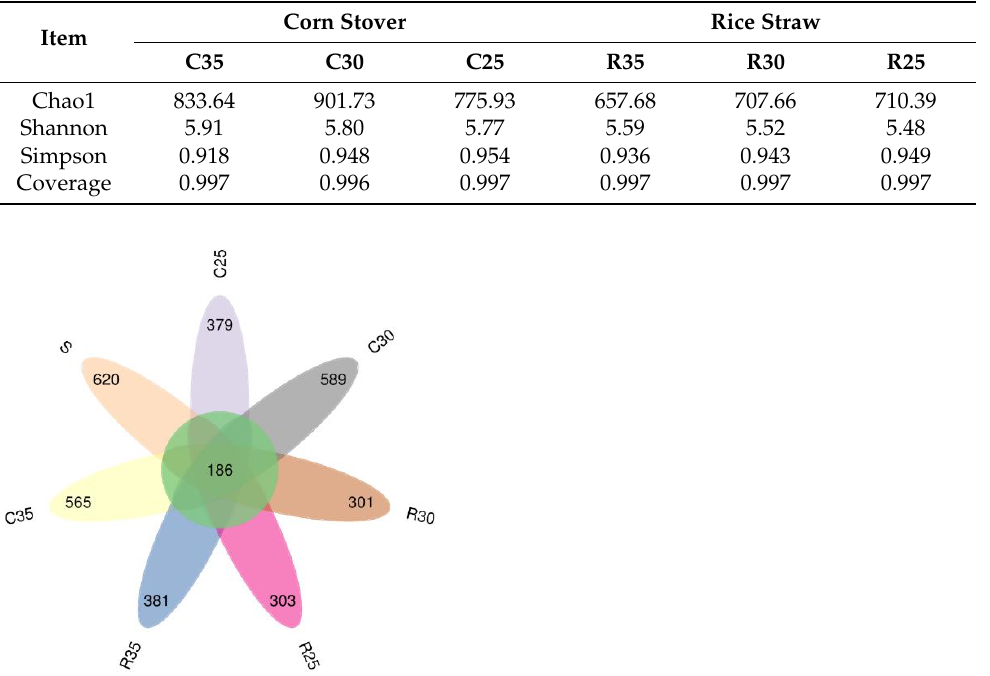
Figure 1. The Venn analysis of operational taxonomic units (OTUs) for corn stover or rice straw silage mixed with soybean curd residue.